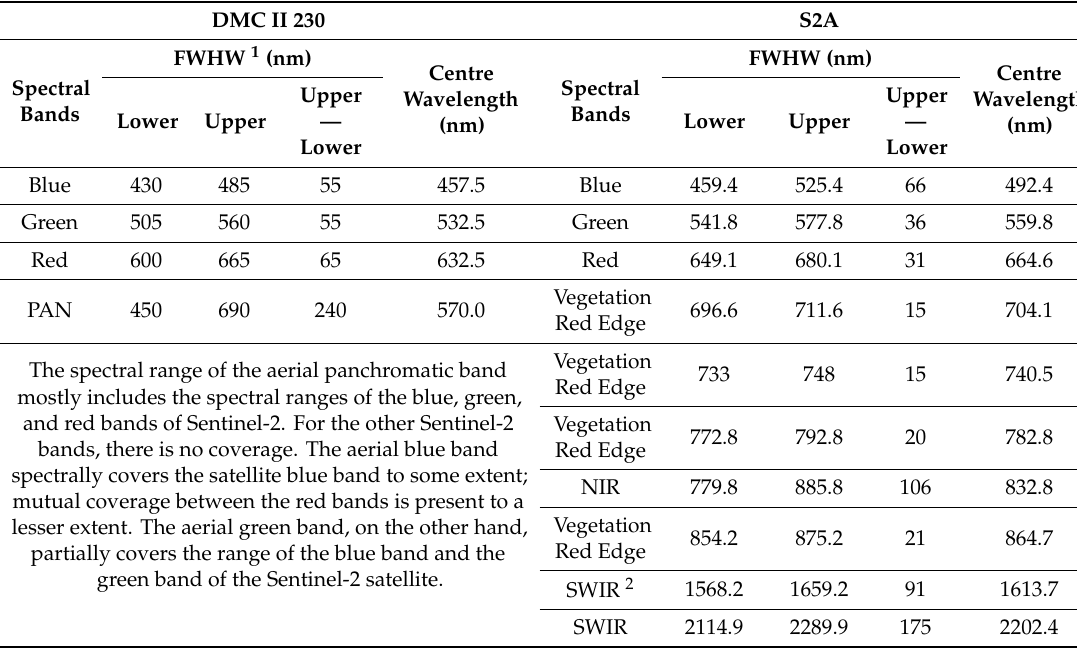
The spectral range of the aerial panchromatic band mostly includes the spectral ranges of the blue, green, and red bands of Sentinel-2. For the other Sentinel-2 bands, there is no coverage. The aerial blue band spectrally covers the satellite blue band to some extent; Table 1. The sensitivity of aerial (DMC II 230) and satellite sensors (S2A); the values for the aerial mutual coverage between the red bands is present to a sensor were read from the camera calibration report and are approximate values. lesser extent. The aerial green band, on the other hand, partially covers the range of the blue band and the green band of the Sentinel-2